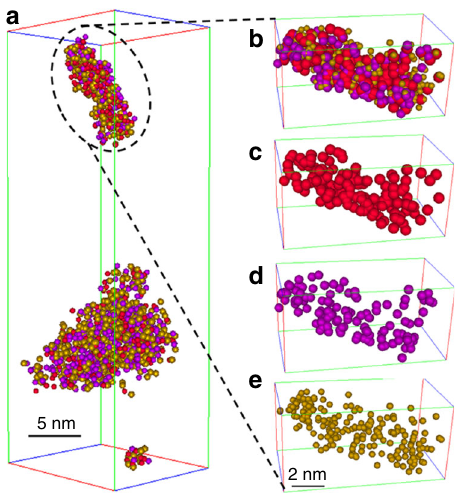
Fig. 2 3D-APT reconstruction of two isolated SA/50 nanoparticles. a All atoms. b Enlargement of the top SA/50 nanoparticle in a , showing only c Al, d Si and e O. The 3D-APT reconstruction of the bottom nanoparticle of a is shown in Supplementary Fig.